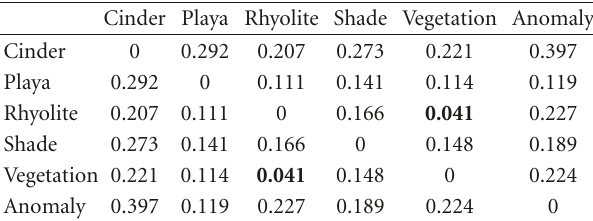
Table 6: SAM values of six signatures in Figure